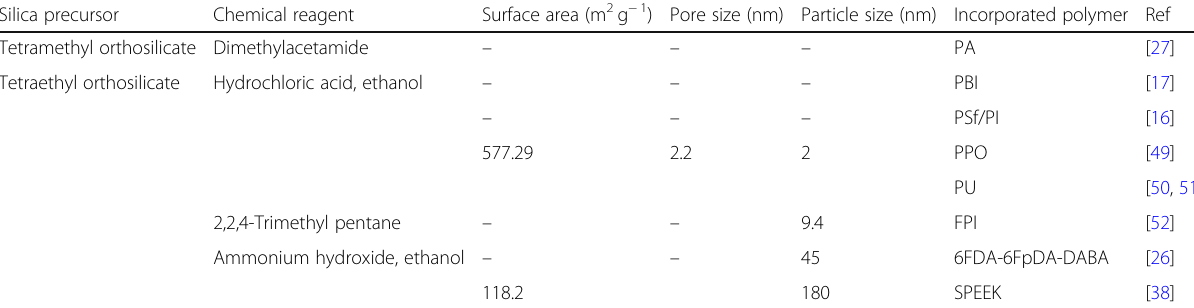
Table 3 Synthesized microporous silica for mixed matrix membranes (MMMs) Silica precursor